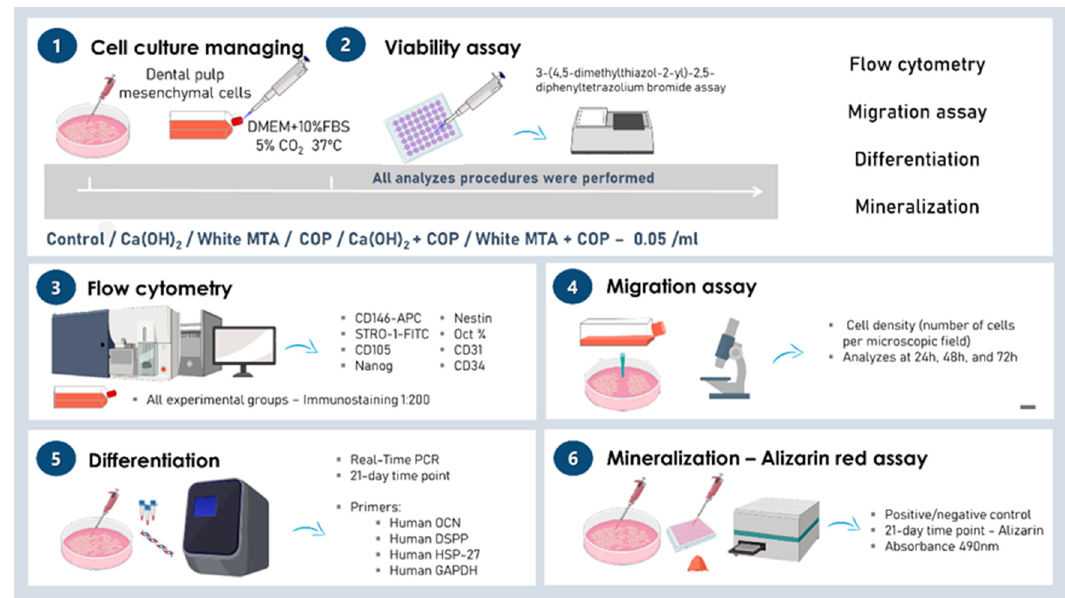
Figure 1. Methodological figure